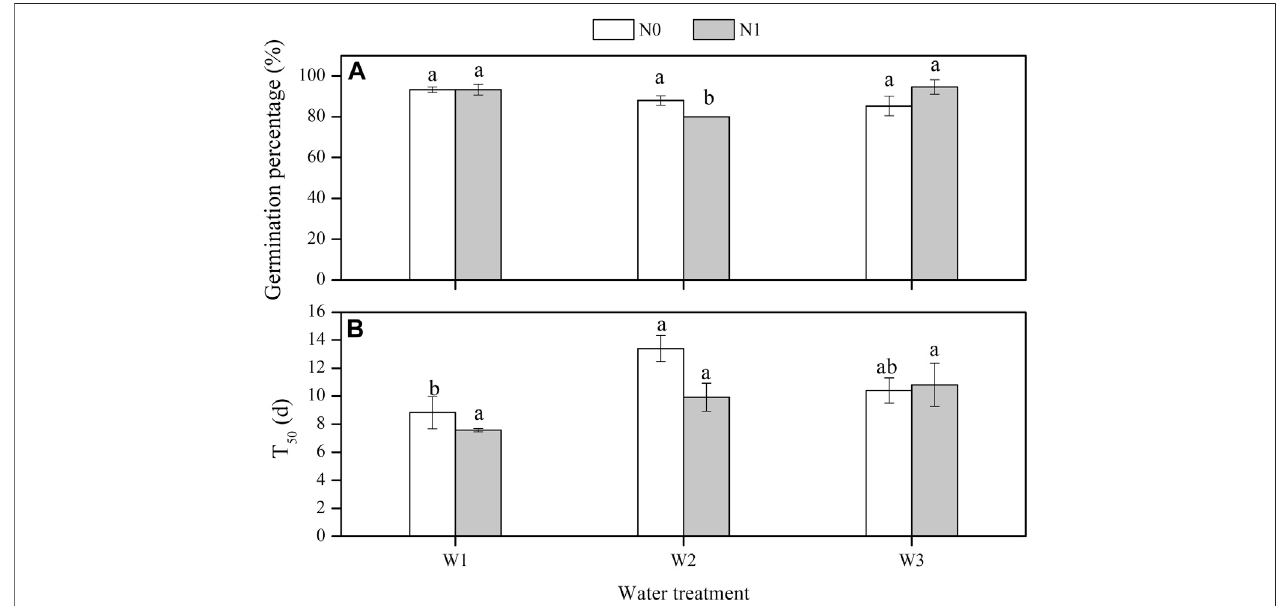
FIGURE3| EffectsofwaterandnitrogenongerminationpercentageandT 50 of L.chinensis (mean ± SE).N 0 ,control,withoutNapplication;N 1 ,Nappliedasureaat 10.5 g N/m 2 ; W 1 , 50% mean annual precipitation (249 mm) (irrigation amount: 96 ml per pot); W 2 , mean annual precipitation (498 mm) (irrigation amount: 193 ml per pot); and W 3 , 150% mean annual precipitation (747 mm) (irrigation amount: 289 ml per pot). Different lowercase letters indicate signi fi cant differences ( p < 0.05) among water treatments at the same level of N